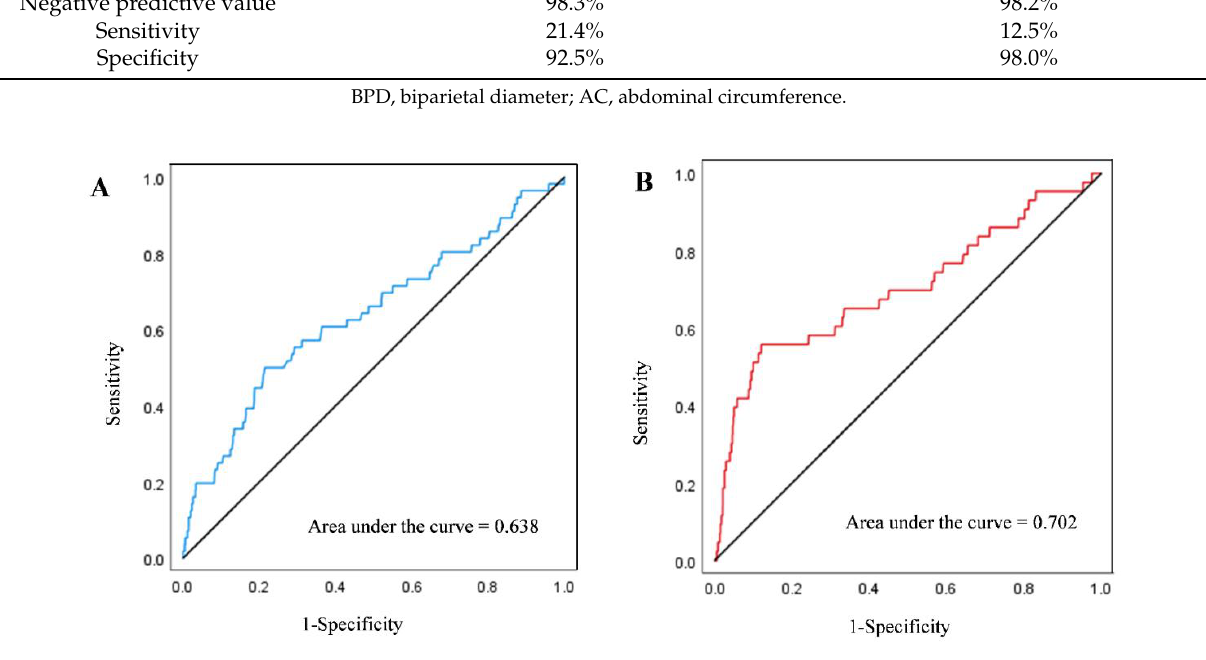
Figure 2. ( A ) Receiver operating characteristic curve of the association between mean difference in gestational age between BPD and AC and placental abruption. ( B ) Receiver operating characteristic curve of the association between EFW at last scan and placental abruption. Abbreviations: BPD, biparietal diameter; AC, abdominal circumference; EFW, estimated fetal weight.